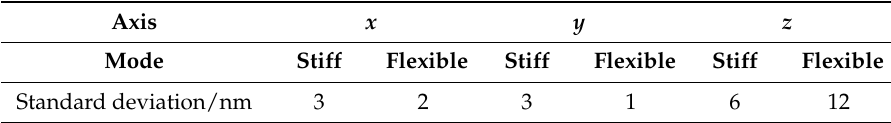
Table 3. Stylus tip positional repeatability following repeated stiffness mode switching, calculated based on a series of eight repeated switches from flexible mode to stiff mode and then back to flexible mode, as illustrated in Figure